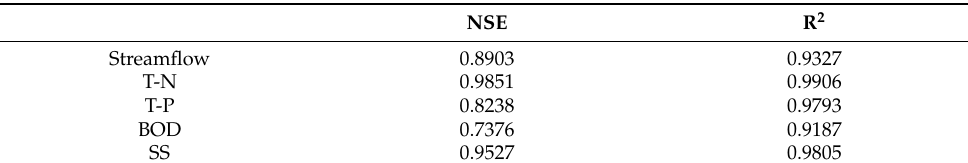
Table 3. NSE and R 2 for measured and estimated monthly streamflow and NPS pollutant loads in model calibration.